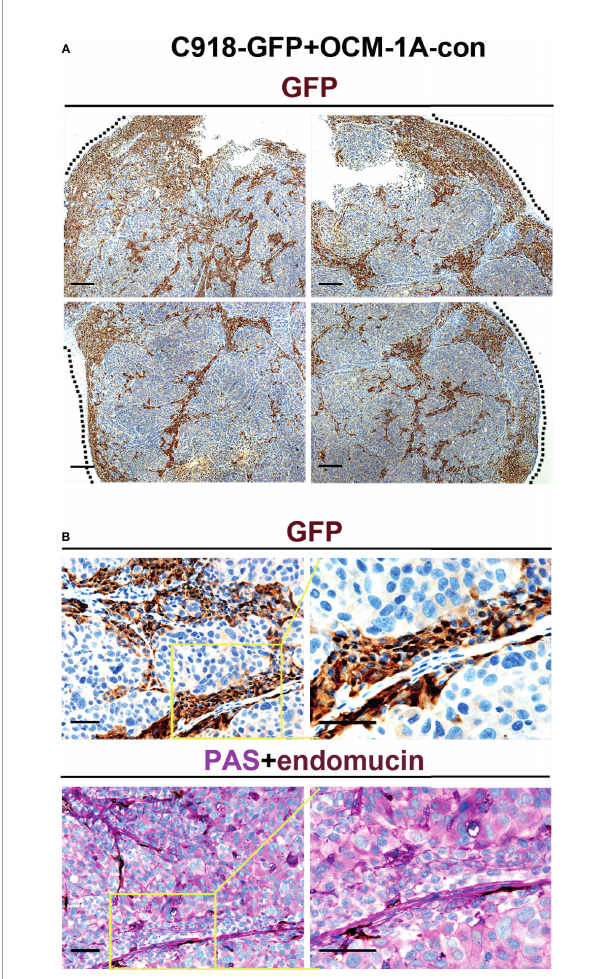
FIGURE 3 | Angiotropism model generated by coxenografting highly and poorly invasive melanoma cells. (A) C918-GFP and OCM-1A-con cells were coinjected subcutaneously into BALB/c-nu/nu mice. By staining for GFP, C918-GFP cells (dark brown) exhibited a conspicuous pericytic location along the blood vessels compared with OCM-1A-con cells. Note the progression of C918-GFP cells along vessels and extending into the tumor invasive front (dashed line) in the low magni fi cations of four directions of a coxenograft. Scale bar 100 m m. (B) Representative GFP-stained sections show the localization of C918-GFP cells on the external surfaces of blood vessels (upper panel). Evidence of intravascular melanoma cells was not identi fi ed. Corresponding serial sections were stained for PAS-endomucin. Blood vessels were positively stained by endomucin throughout the tumors and correlated with the characteristic extracellular matrix-rich patterns (lower panel). Scale bar 50 m